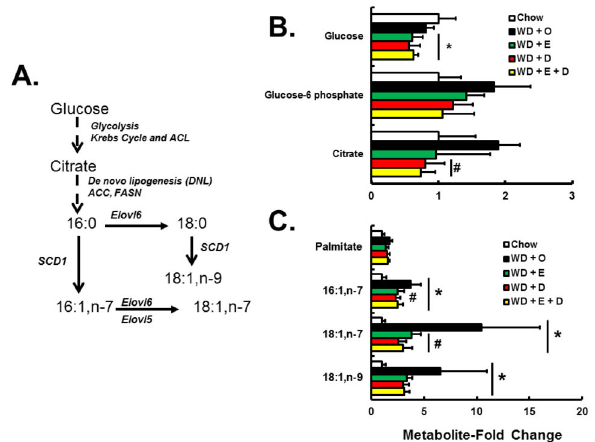
Figure 8. Diet effects on glucose metabolism and de novo MUFA synthesis. Panel A: Glucose conversion to saturated and monounsaturated fatty acids. Panel B: Metabolites involved in glucose metabolism were quantified by the metabolomic analysis and expressed as Metabolite-Fold Change; mean ± SD, n=8 per group. Panel C: Metabolites involved in de novo MUFA synthesis were quantified by the metabolomic analysis and expressed as Metabolite-Fold Change; mean ± SD, n=8 per group; *, p ≤ 0.05 versus chow; #, p ≤ 0.05 versus WD + O.